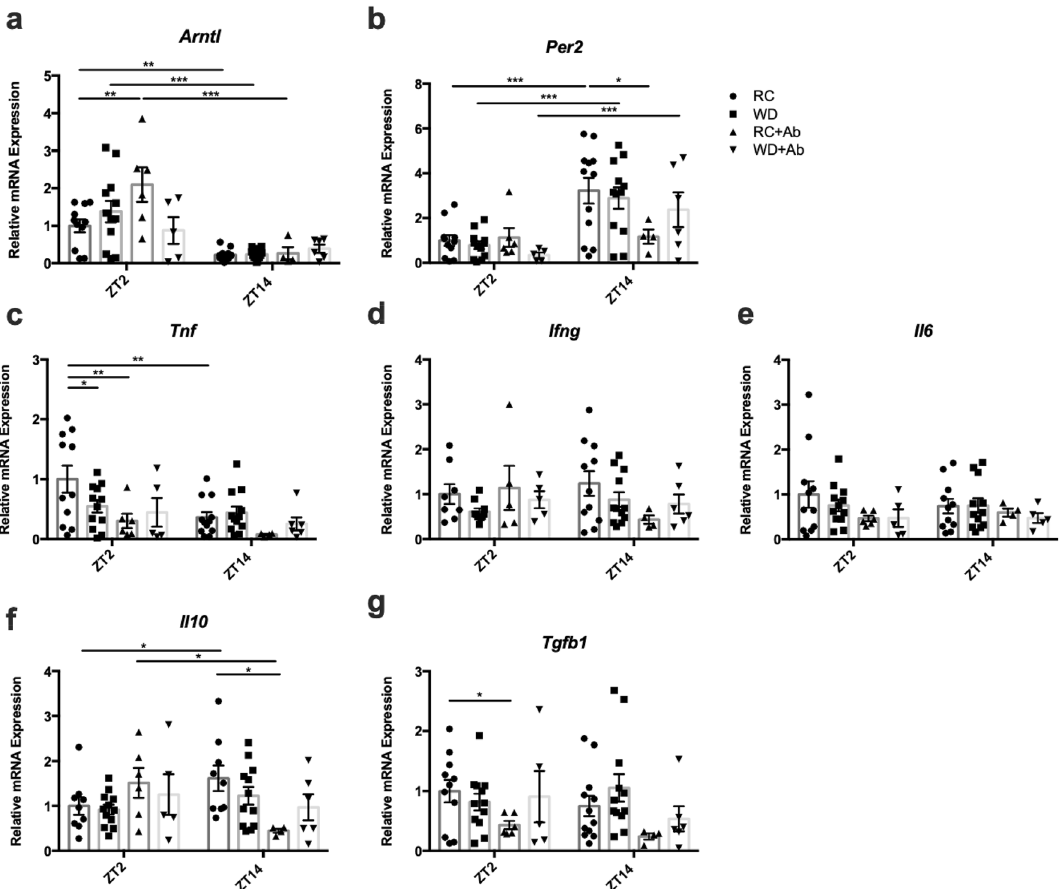
Figure 3. Intestinal mucosal gene expression is altered by WD-feeding and microbial disruption. ( a ) Arntl , ( b ) Per2 , ( c ) Tnf , ( d ) Ifng , ( e ) Il6 , ( f ) Il10 , and ( g ) Tgfb mRNA expression measured from SI mucosa isolated at ZT2 and ZT14 from RC- and WD-fed animals with and without AIMD. n = 2–6 male and 2–6 female mice. * p < 0.05 ** p < 0.01 *** p <